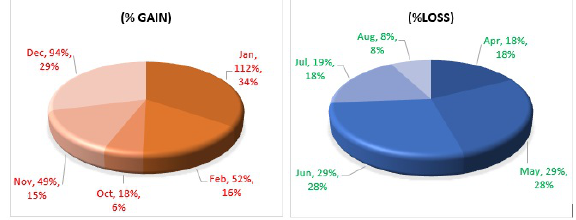
Fig. 14. Temperature gain/ loss of the air (left: % gain, and right: %